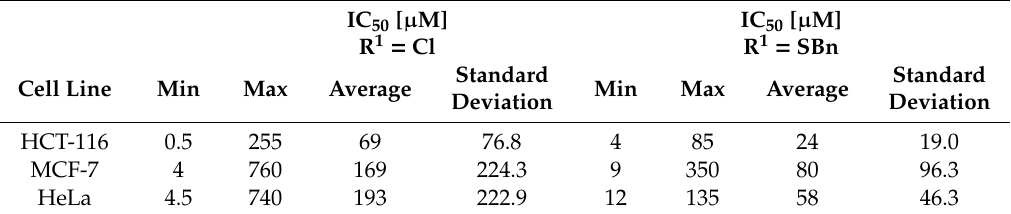
Table 3. Basic statistical parameters for anticancer activity (IC 50 [ µ M]) of two groups of compounds R 1 = Cl and R 1 = SBn.